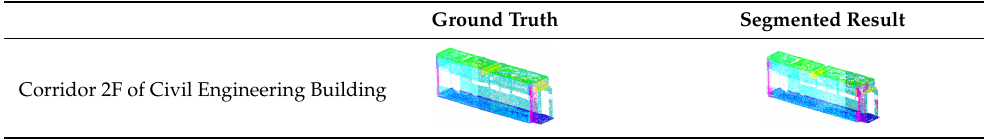
Table 6. Categories of ground truth and segmented results for corridor 2F of civil engineering